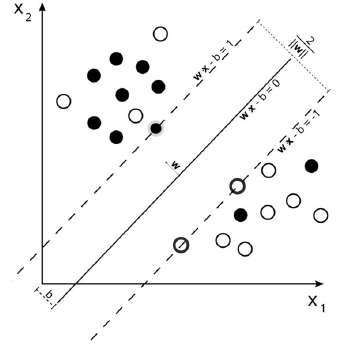
Figure 6. Non linearly separable